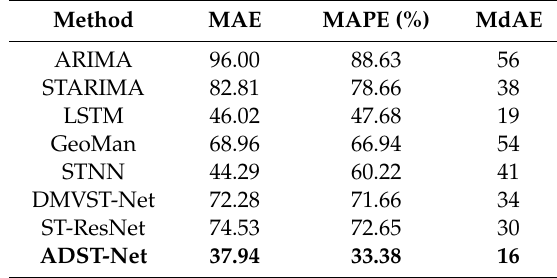
Table 6. Prediction Performance at Multiple Time Steps (U = 5).